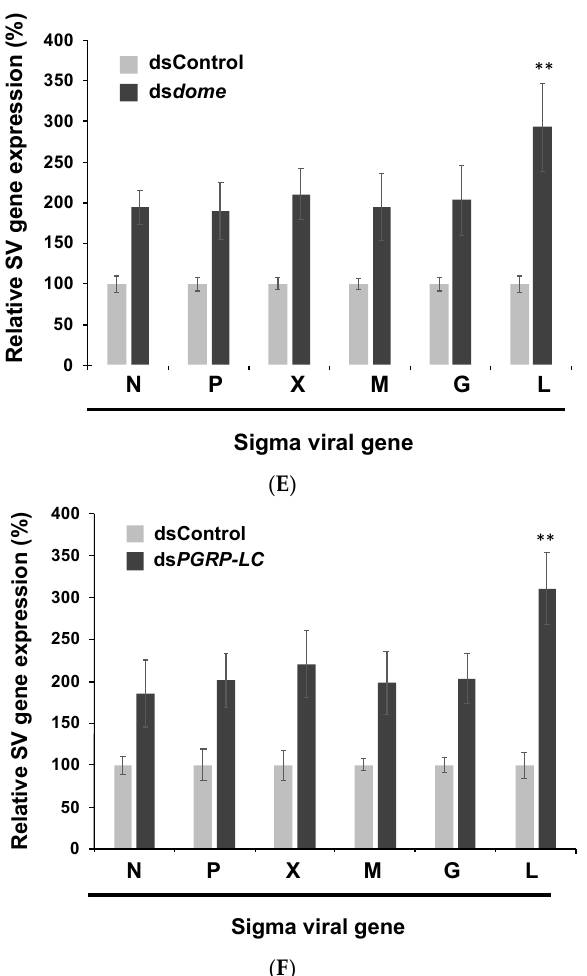
Figure 4. Knockdown of domeless and PGRP-LC enhanced the sigma virus replication in flies. ( A ) Green fluorescent protein (GFP) transgenic flies were injected with ds gfp and then reared for 3 days. The fluorescence was quenched in ds gfp -injected flies, indicating successful knockdown of the target gene by dsRNA injection. ( B ) RT-qPCR analysis of domeless and PGRP-LC gene expression in ds RNA injected flies. ( C ) The RT-qPCR analysis of sigma virus copies in sigma-virus-infected domeless and PGRP-LC knockdown and untreated flies. ( D ) The survival rate of sigma-virus-infected flies in domeless and PGRP-LC -knockdown flies upon CO 2 exposure. ( E , F ) RT-qPCR analysis of sigma virus copies in sigma-virus-infected domeless and PGRP-LC -knockdown and untreated flies. We set the dsControl group as 100% expression. The mean and SD are shown. ** p < 0.005, one-sample t -test. All experiments were performed with three replicates.